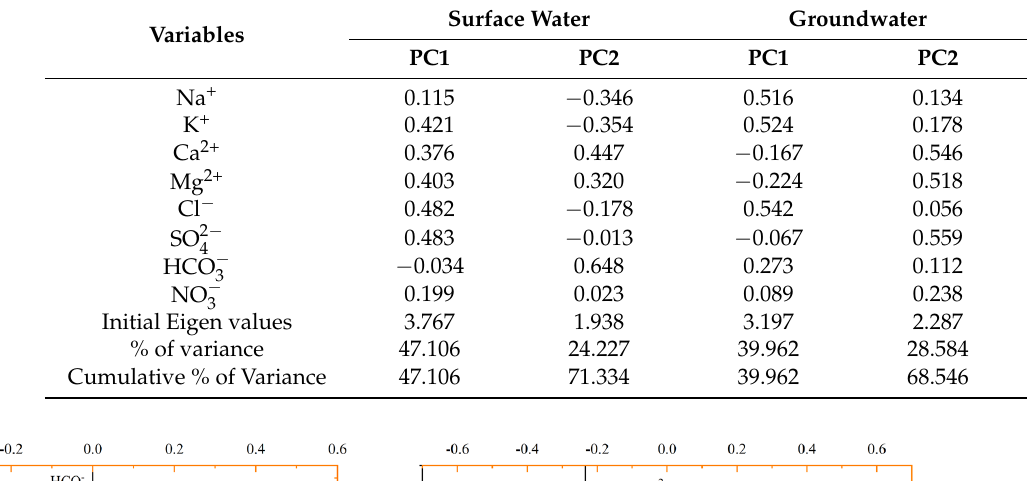
Table 4. PCA representation for surface water samples and groundwater samples in Nandong Karst Water System (NKWS).